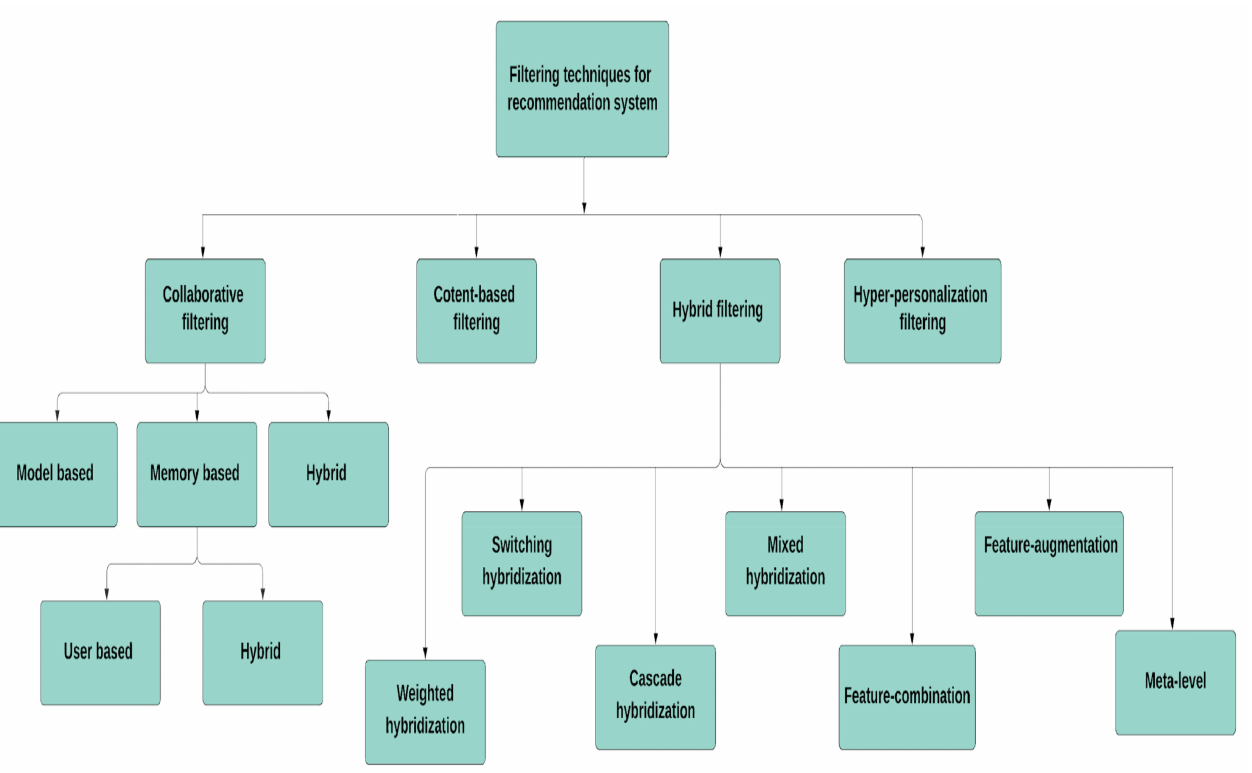
Figure 3. Classification of filtering techniques for recommendation systems.